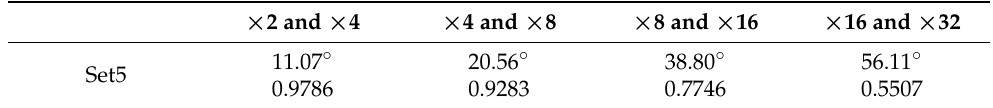
Table 2. Cosine angle and cosine similarity of pixel distribution probability between adjacent levels of down-sampled images in Set5